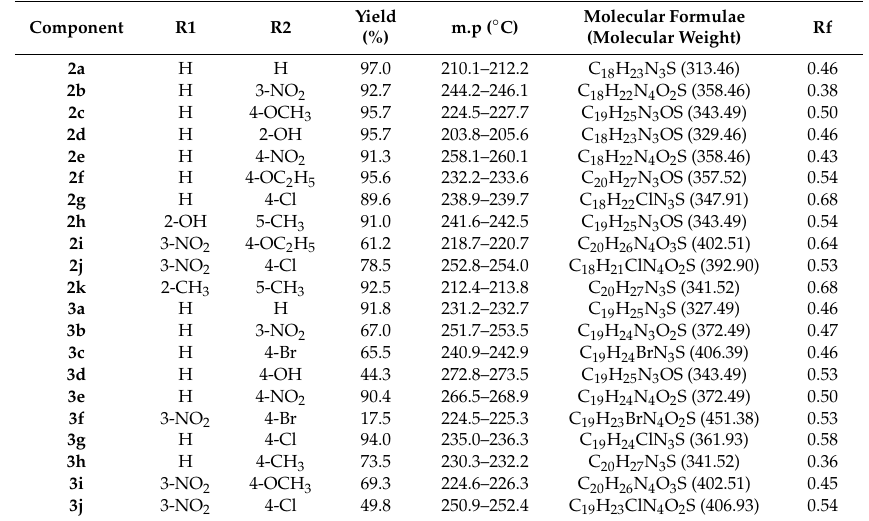
Table 1. Melting point (m.p), yield (%), molecular formulae (Mol.For.), molecular weight (Mol. Wt.) and Rf of thiosemicarbazones 2a – k and 3a – j .